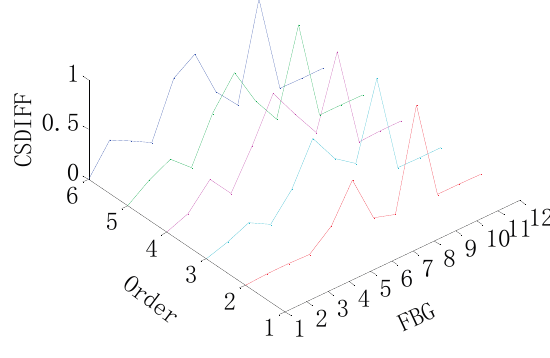
Figure 8. CSDFIF for two-damage detection.